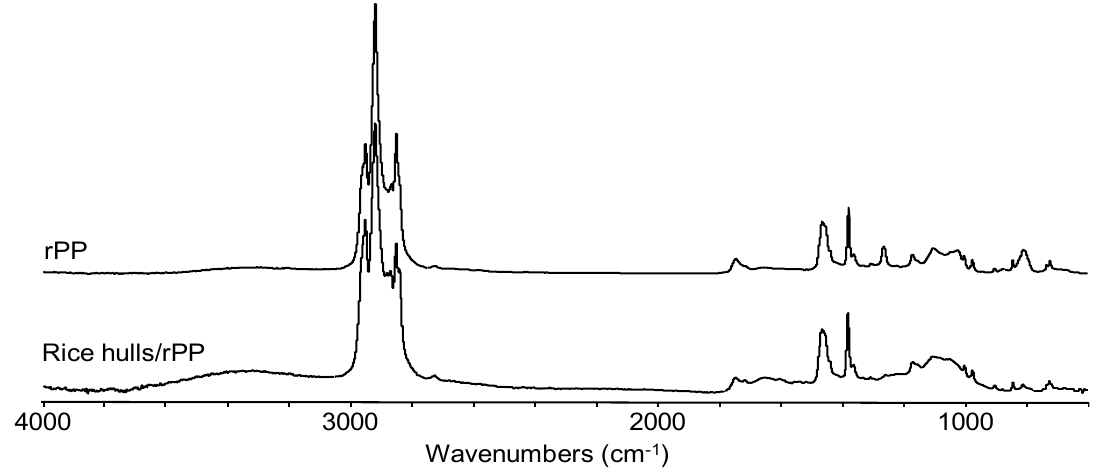
< 0.5 mm) / rPP composite